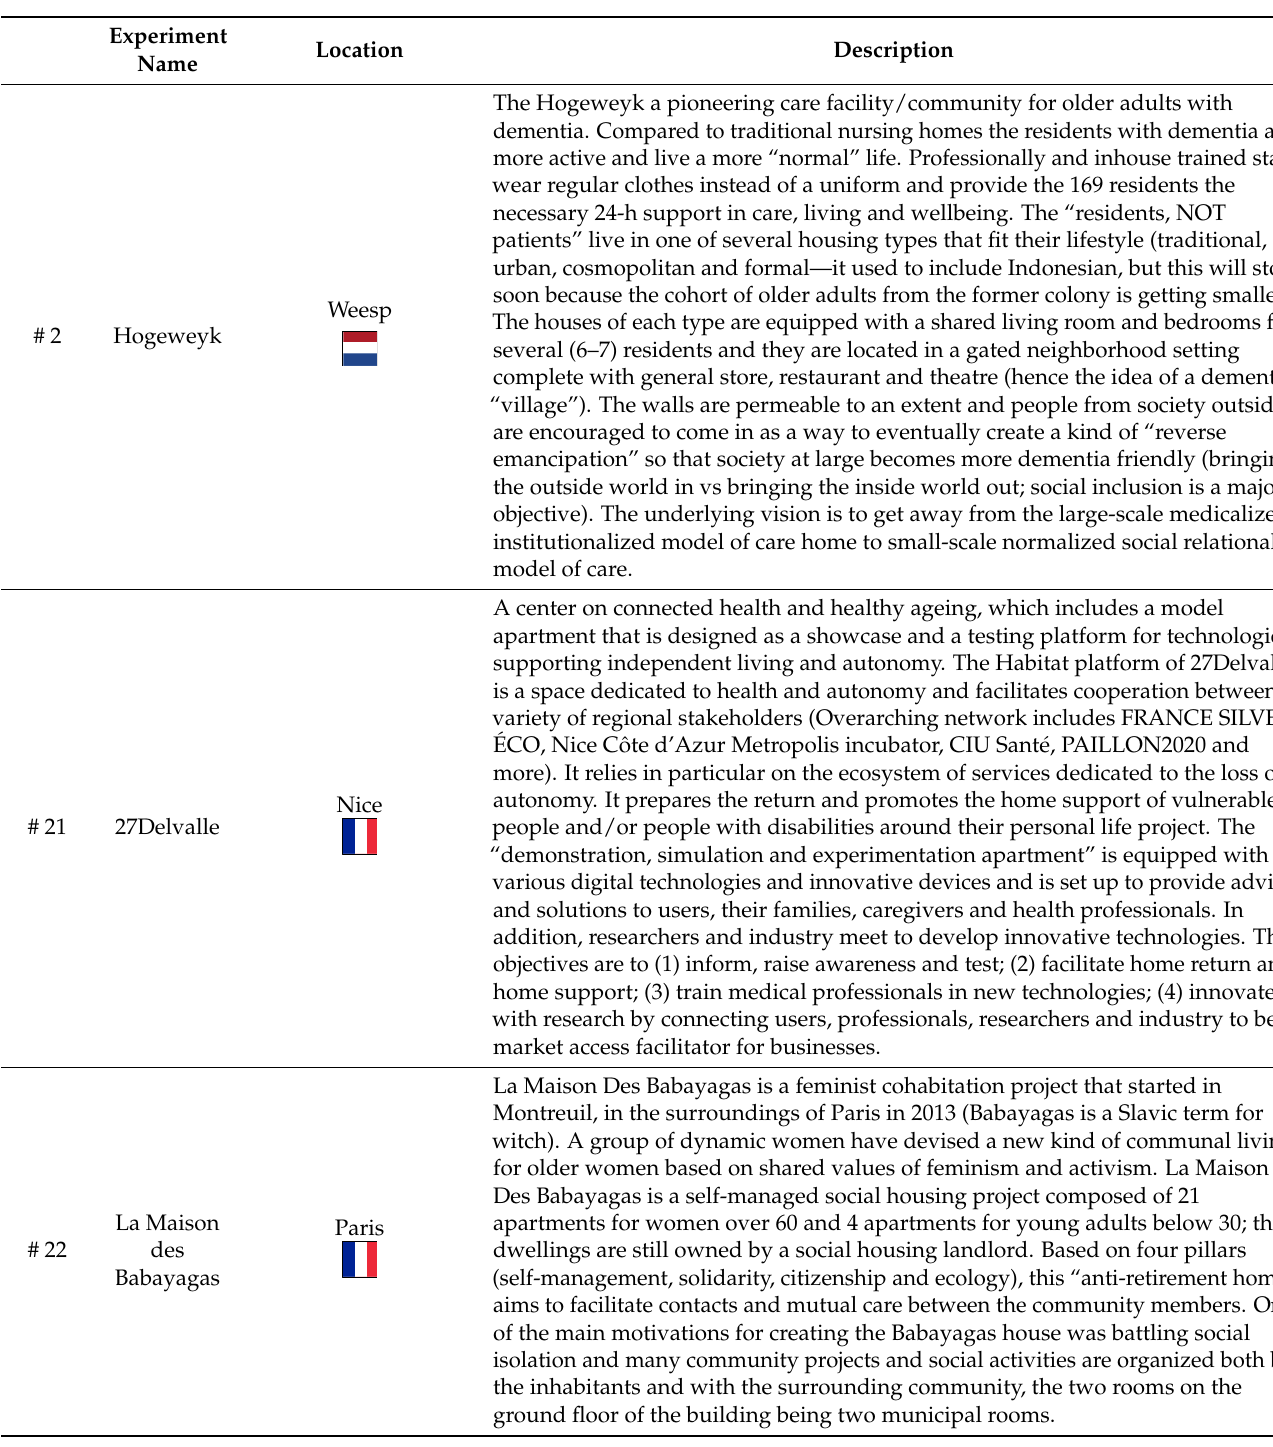
Table 2. Overview of 8 key age-friendly home experiments in the Netherlands, France, Ireland and Poland (see Table A1 in Appendix A for the complete overview of 53 Table 2. Cont.